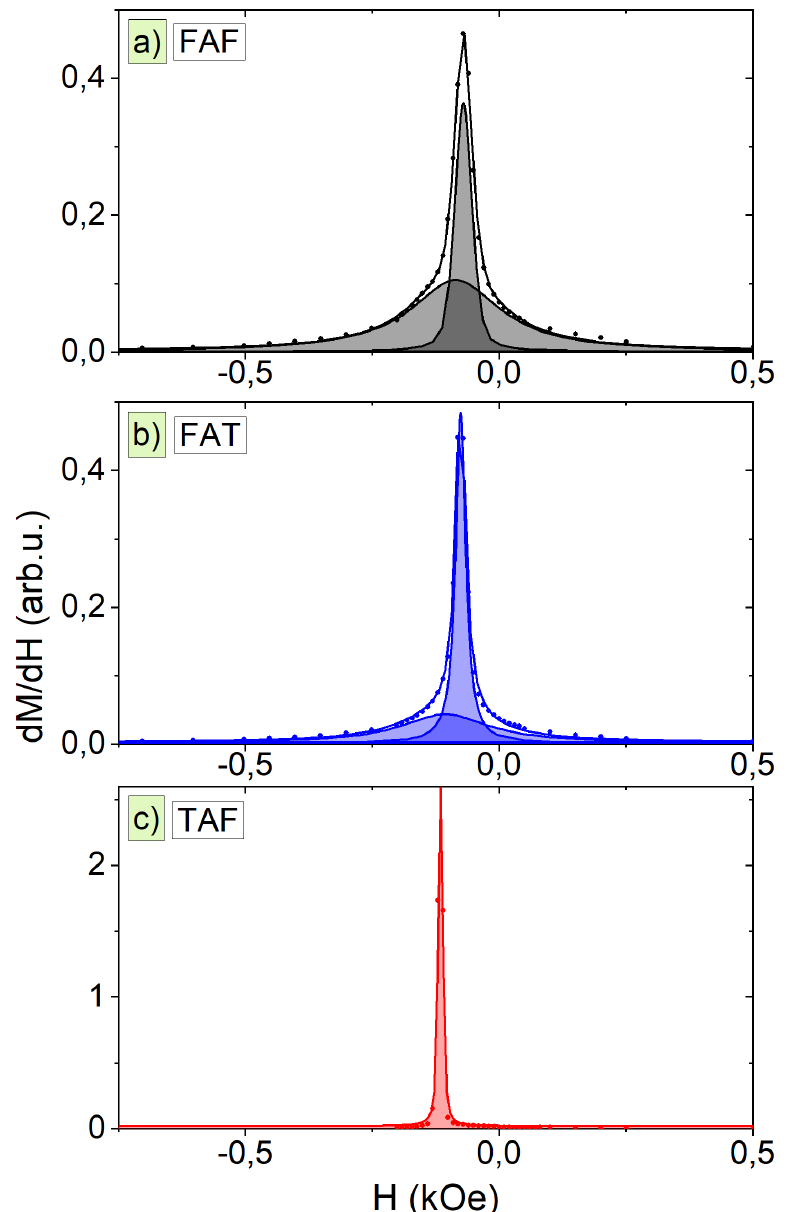
Figure 6. A magnetization derivative of hysteresis curves for ( a ) FAF, ( b ) FAT, and ( c ) TAF junctions measured at 300 K for H (cid:107) S